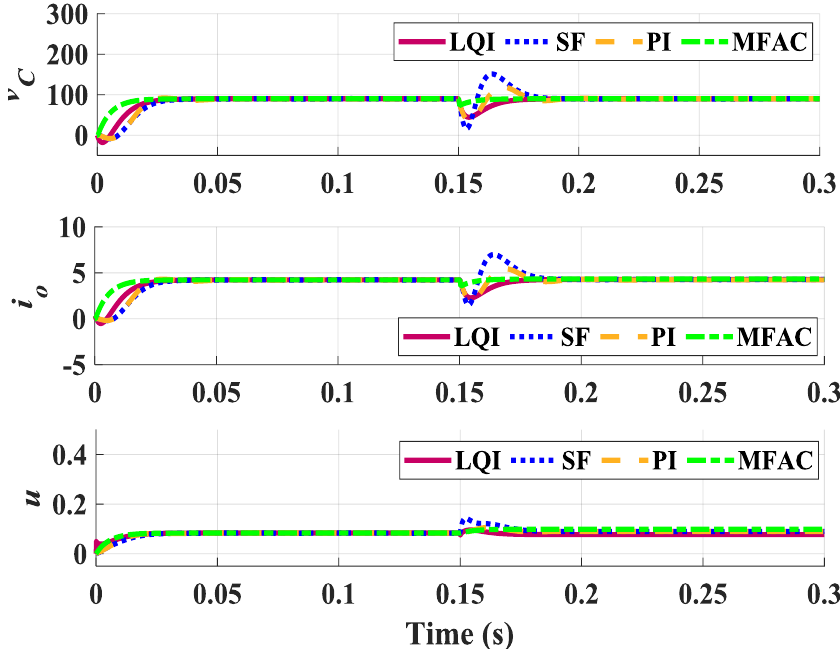
Figure 4. Nominal closed-loop response for a 4 A load disturbance ( D = 0.4347, R o = 27).